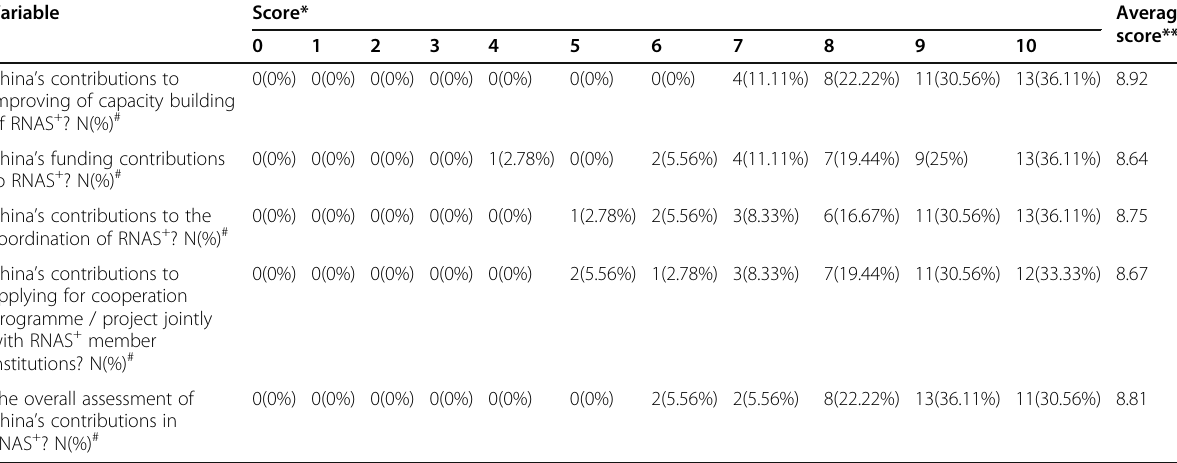
Table 3 Assessment score of China ’ s contributions to RNAS + by survey respondents Variable